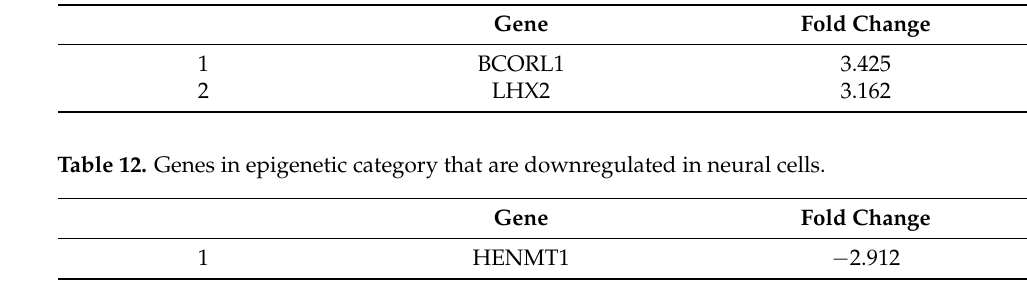
Table 11. Genes in epigenetic category that are upregulated in neural cells. Gene Fold Change 1 BCORL1